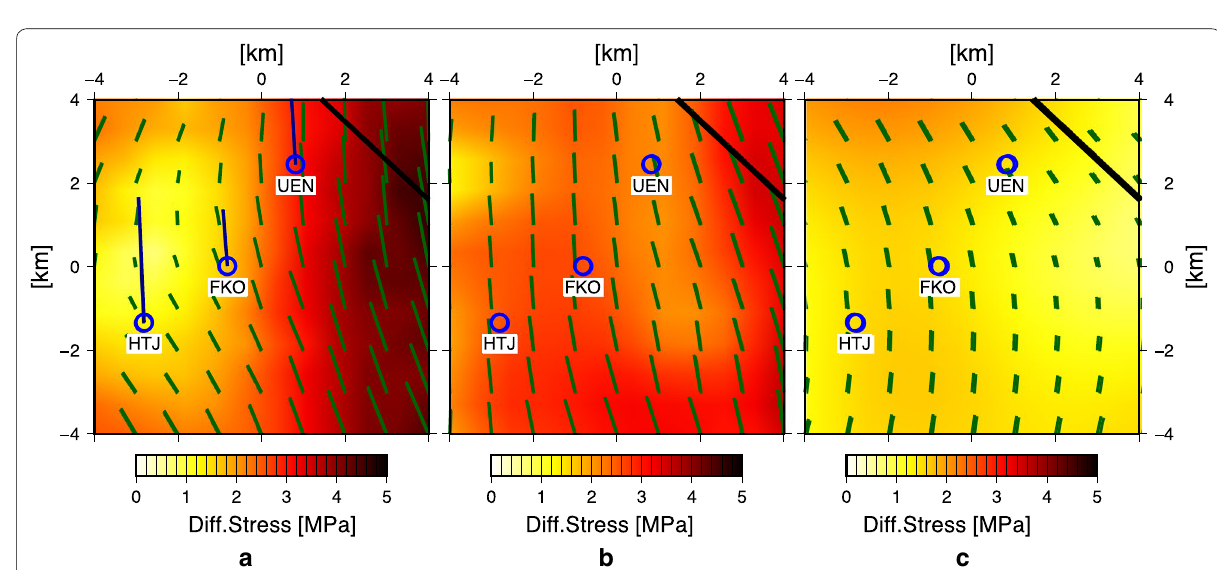
Fig. 2 Calculated differential stress and maximum compressional axis at the depth of a 300 m (at MSL), b 1.3 km (1 km below MSL), and c 5.3 km (5 km below MSL). The green lines indicate the magnitude of calculated differential stress and the direction of maximum compressional axis. The blue lines in ( a ) denote the Yamashita et al. (2010)’s result. The color indicates the magnitude of differential stress. The blue circles denote the locations of Yamashita et al. (2010)’s hydraulic fracturing test were carried out. The upper‑right thick back line is the Atera fault